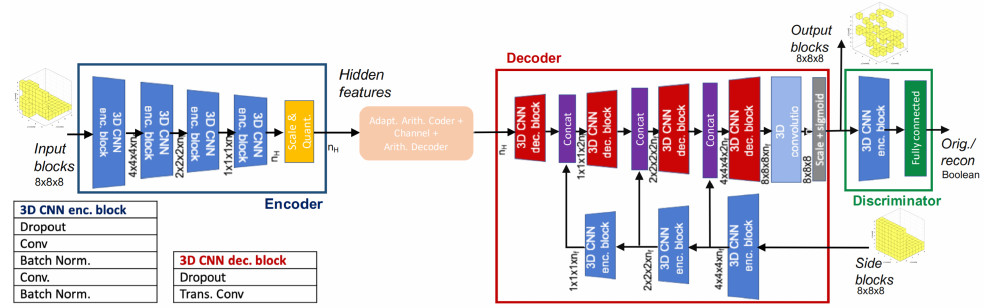
Figure 16. Scheme of the architecture proposed in [106].